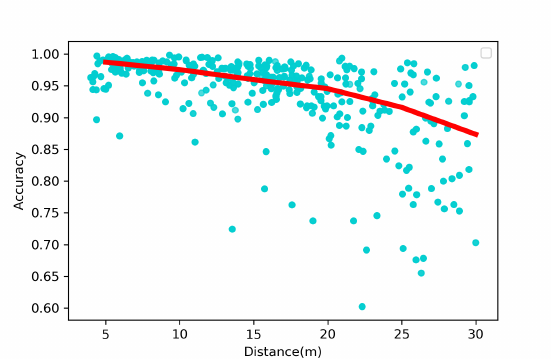
Figure 11. Thousands of objects have been tested, and the accuracy rate distribution is shown in the scatter plot. The trend is drawn and it is found that as the distance increases, the accuracy rate will